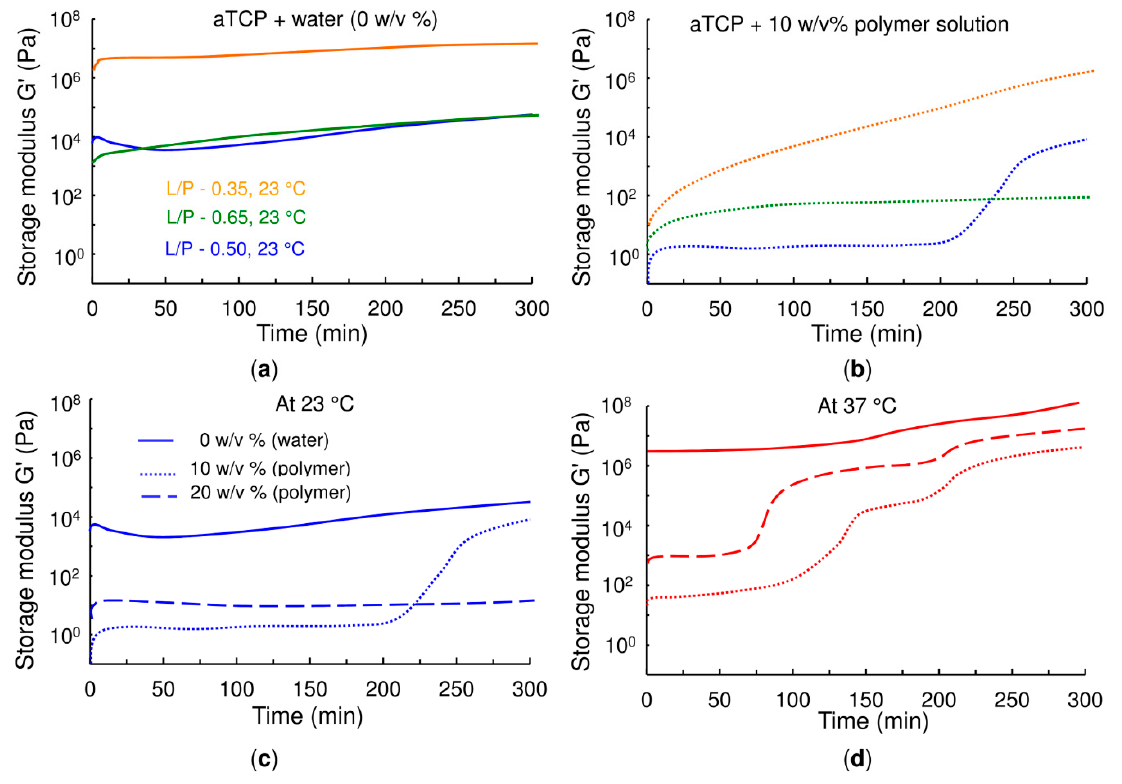
Figure 2. Time-sweep curves of alpha-tricalcium phosphate ( α -TCP) cement pastes with ( a ) and ( b ) differing liquid to powder (L/P) ratios (0.35; 0.5; 0.65 g · g − 1 ) and liquid phases (0 w / v % water and 10 w / v % polymer solution) at 23 ◦ C (the curves determined for the α -TCP cement pastes with the 20 w / v % polymer solution are shown in Supplementary Figure S4), ( c ) and ( d ) a constant L/P ratio of 0.5 g · g − 1 and differing polymer solution concentrations (0 w / v %, 10 w / v % and 20 w / v % polymer solutions) at 23 and 37 ◦ C, respectively.